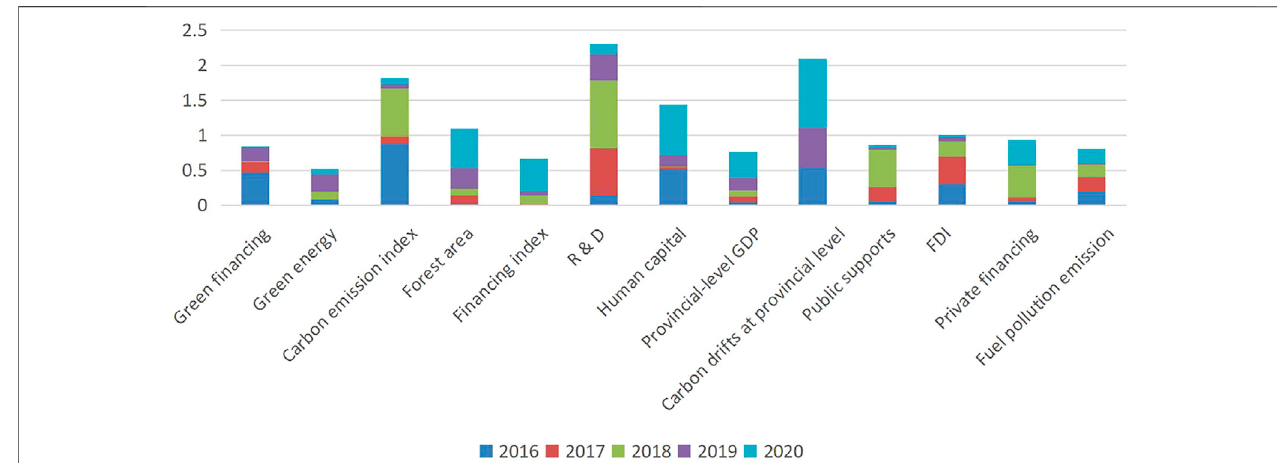
FIGURE 3 | Periodic estimates of study constructs over the period of inquiry.